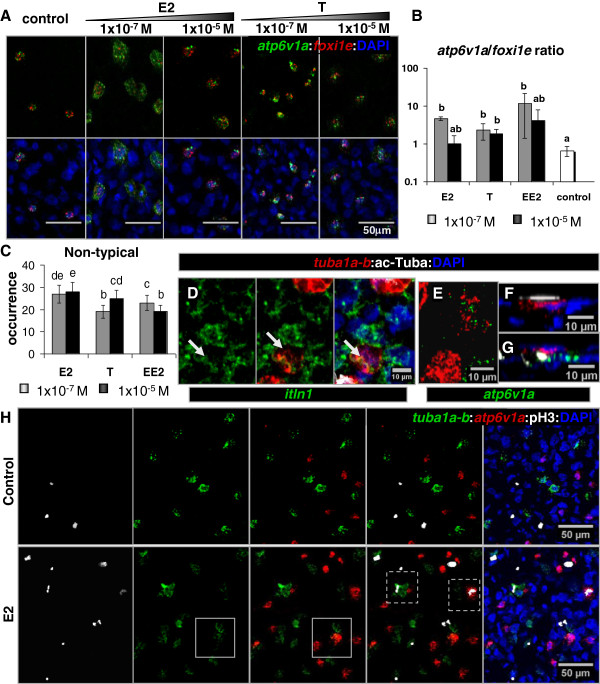
Sex steroids induced “non-typical” phenotypes in epidermal MCE of Xenopus embryos. A) Enhanced atp6v1a signal in MR cells treated with E2 or T. Staining: Double FISH for atp6v1a (green) and foxi1e (red), and DAPI, 2 μm stack. B) Quantification of atp6v1a enrichment based on the ratio of atp6v1a to foxi1e signal areas in single cells, d.f. = 69. C) Accumulative occurrence of “non-typical” phenotypes by condition. “Non-typical” phenotypes were not detected in controls. D) “non-typical” double itln1: tuba1a-b cell without cilia (arrow) in an EE2-treated embryo. Staining: Double FISH for itln1 (green) and tuba1a-b (red), IHC for ac-Tuba, and DAPI, 2 μm stack. E) “non-typical” double atp6v1a: tuba1a-b cell in a T-treated embryo, 2 μm stack. F,G) Orthogonal view of a normal MC cell (B) and “non-typical” double atp6v1a: tuba1a-b cell with internalized cilia in a T-treated embryo. B-D) Staining: Double FISH for atp6v1a (green) and tuba1a-b (red), IHC for cilia marker acetylated-tuba (ac-Tuba), and DAPI. H) Induction of proliferative MR and MC (dashed-line squares), and double atp6v1a: tuba1a-b cells (square). Staining: Double FISH for tuba1a-b (green) and atp6v1a (red), IHC for proliferation marker phospo-histone3 (pH3), and DAPI, 2 μm stack. A,D-H) Data from confocal microscopy imaging analysis. C-H) “non-typical” data corresponds to a screening of 64 embryos by condition. B,C) Mean ± SD, “a” = control group; statistical significance is represented in a letter code: a indicates no difference with control, all other letters indicate significant difference with the control, shared letters indicate no significant differences between the corresponding data sets. One-way ANOVA, Tukey comparison test, p < 0.05. MC = multiciliated, vMR or rMR = vesicle or ridged mitochondrion-rich, MS = mucus-secreting cells.